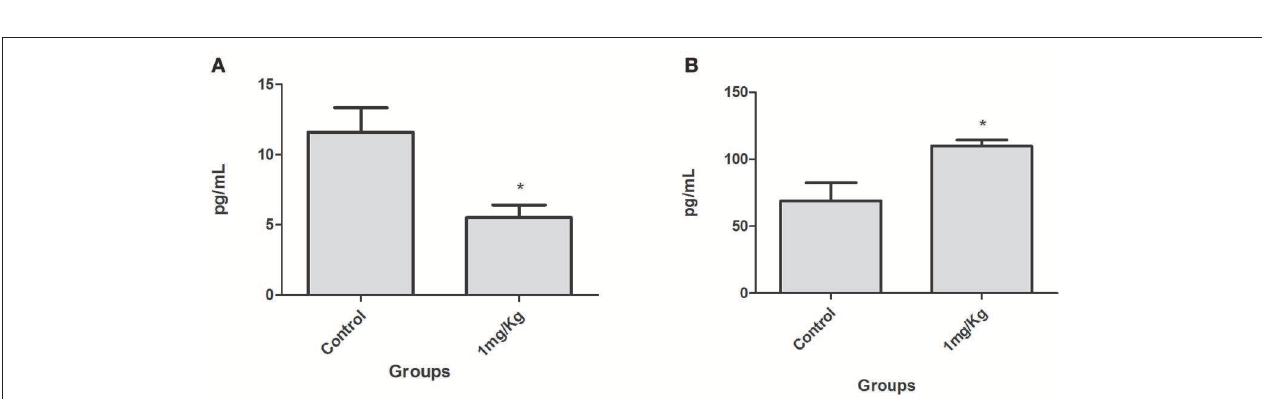
FIGURE 2 | In vivo efficacy of SERT. After 5 days of infection with L. (L.) infantum , BALB/c mice were treated for 10 consecutive days. (A) Parasite burden (%) of the treatment with free sertraline in oral administration. (B) Parasite burden (%) of the treatment with liposomal sertraline in subcutaneous administration. (C) Parasite burden (%) of the treatment with free sertraline in subcutaneous administration. * p < 0.05.